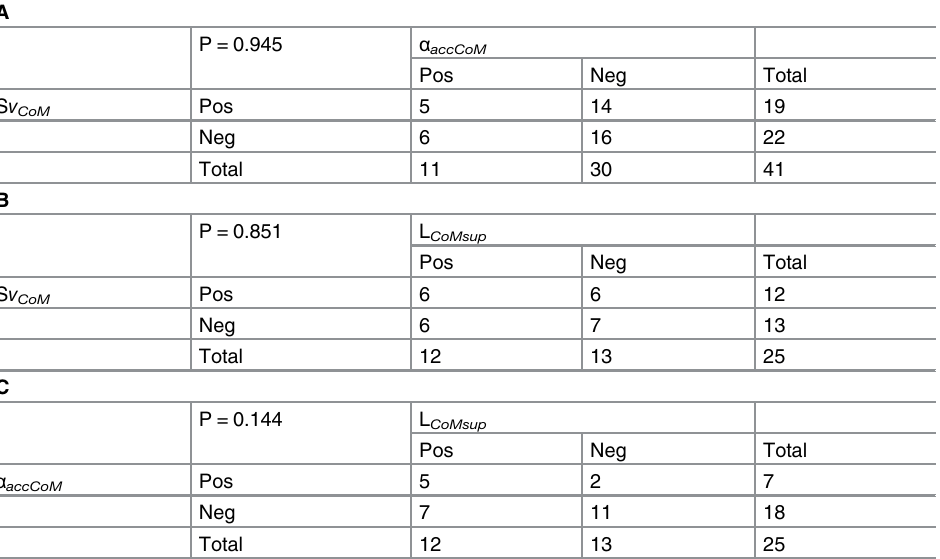
Table 2. Odds ratios for incidences of breakpoints (Pos) or continuity (Neg) as indicated by statistical comparison of the piecewise function (eqs 5a and 5b) and the exponential function (eq 4) for S v CoM , α accCoM and L CoMsup .